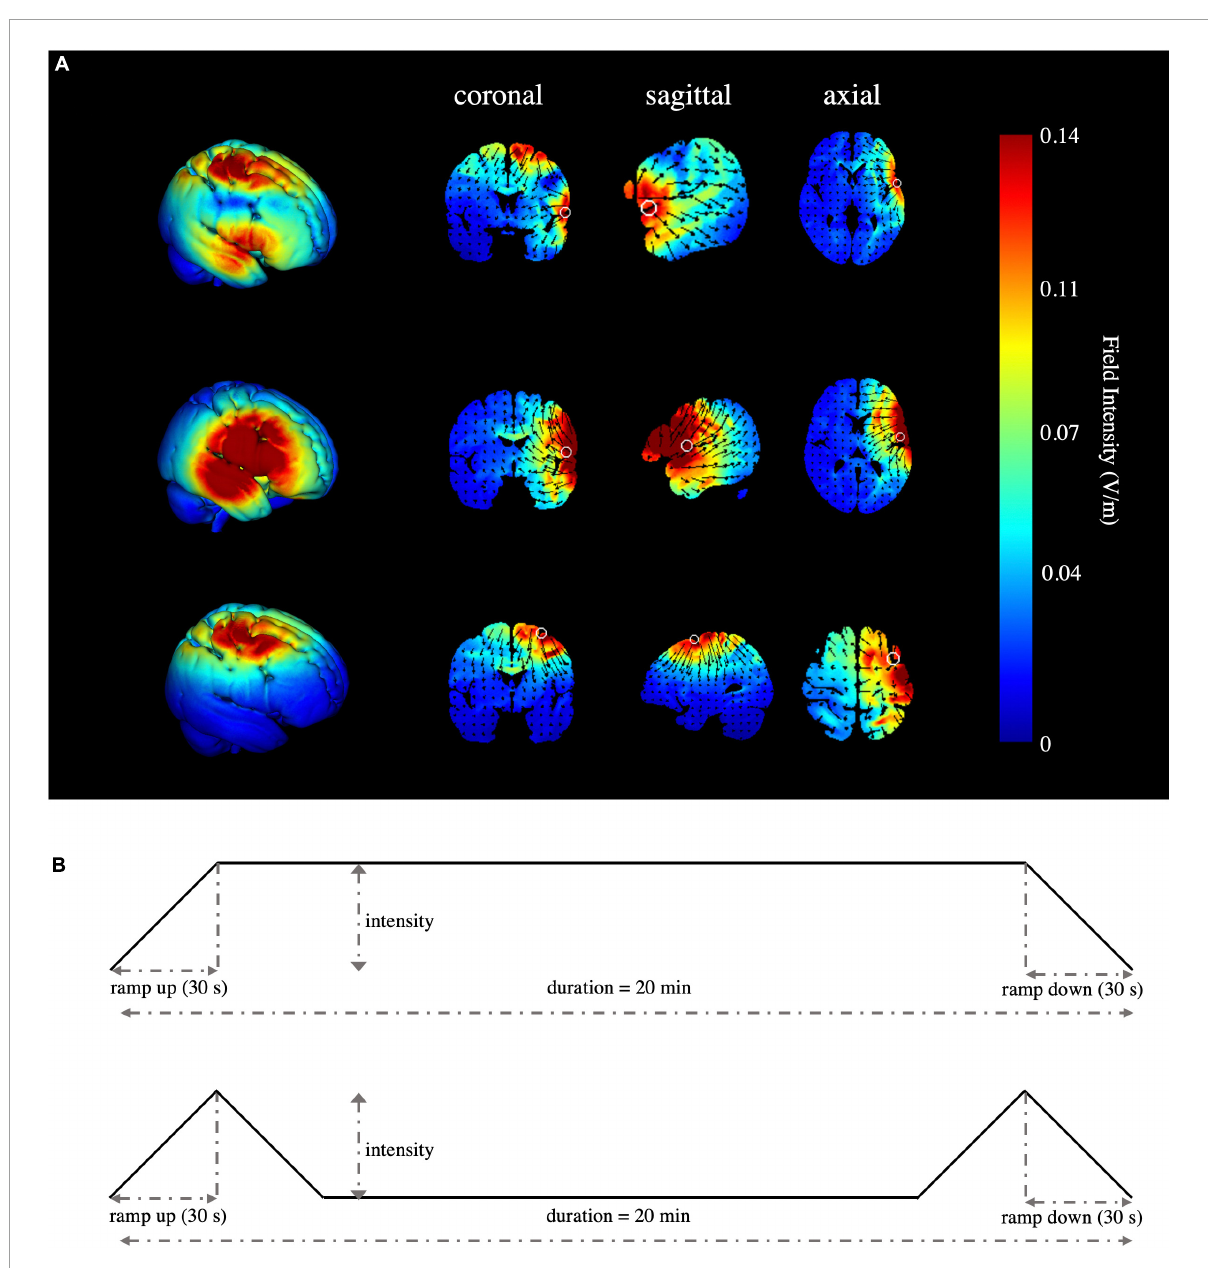
FIGURE2 Simulated stimulation conditions and time progression of tDCS. (A) Simulated electric field and current flow of rIFG + pre-SMA (top), rIFG (middle), and pre-SMA (bottom). The color bar represents the field intensity and the arrow points in the direction of current flow. Column 1 is a 3D view, while column 2 to column 4 range from coronal to axial slices. (B) Schematic illustration of the duration of tDCS, ramp-up, and ramp-down periods for verum (top) and sham stimulation (bottom). The current intensity was delivered at 1.25 mA for single-target HD-tDCS, 2.5 mA for multitarget HD-tDCS, and 1.25 mA or 2.5 mA in a pseudo-random order for the sham stimulation